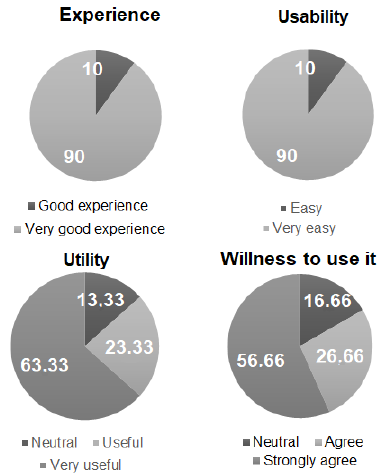
Figure 2. Survey results regarding WAY2AGE usability.